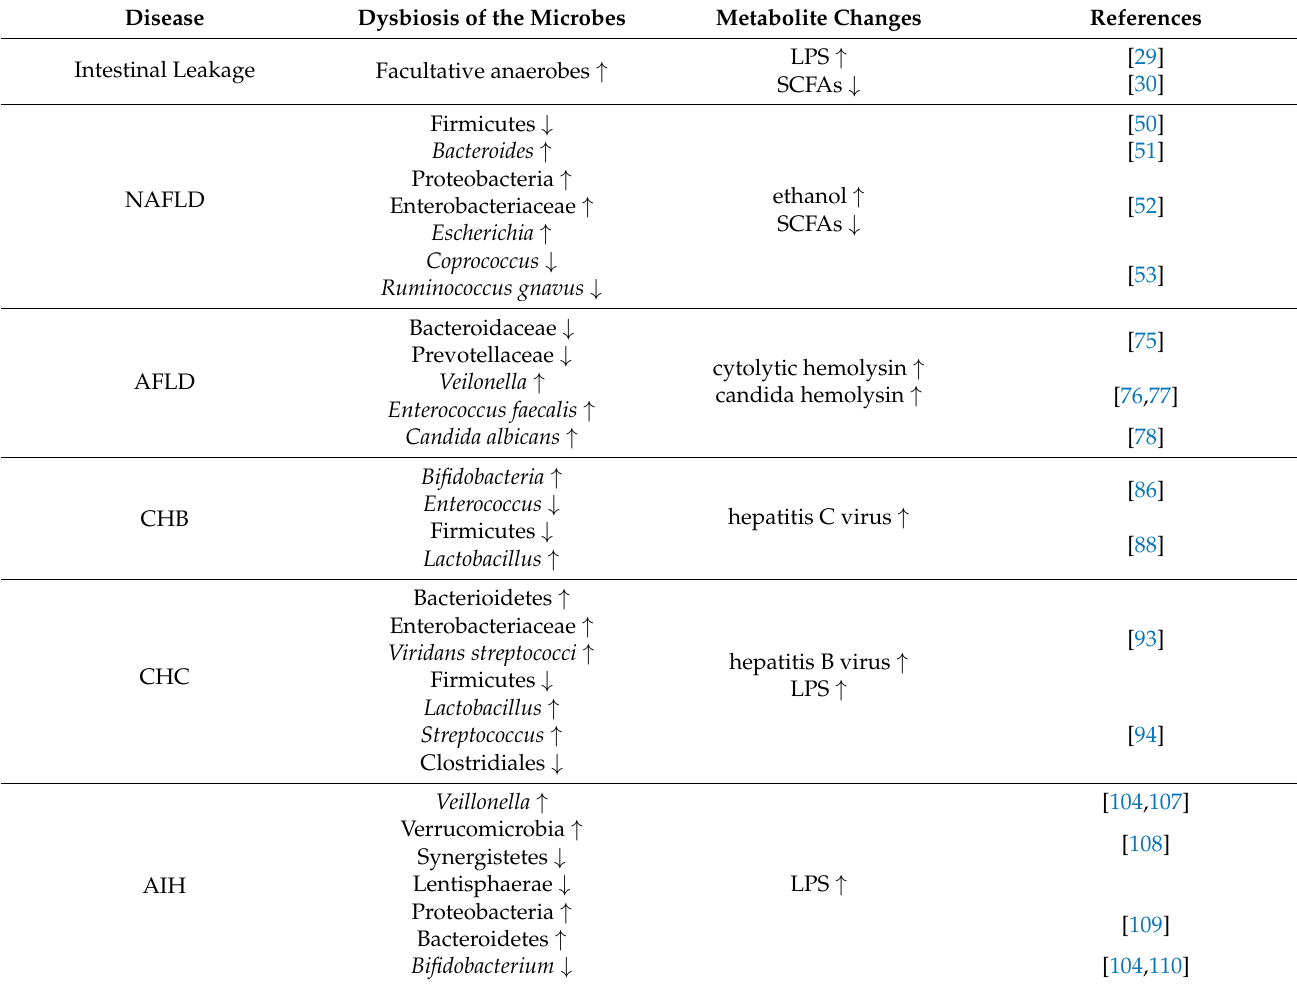
Table 1. Dysbiosis of intestine microbes in chronic liver diseases. Disease Dysbiosis of the Microbes Metabolite